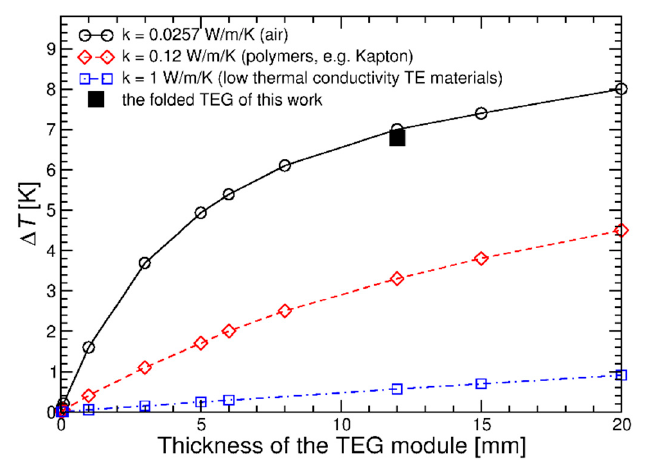
Figure 2. ( a ) Simulated temperature gradient ( Δ T ) available for power production as a function of the thickness of the thermoelectric module prepared of different materials. The initial temperature gradient was set to 10 K by applying a constant temperature of 33 °C on the “hot” surface and the air of the opposite side (“cold”) to 23 °C. Free convection was applied between the 23 °C air and the